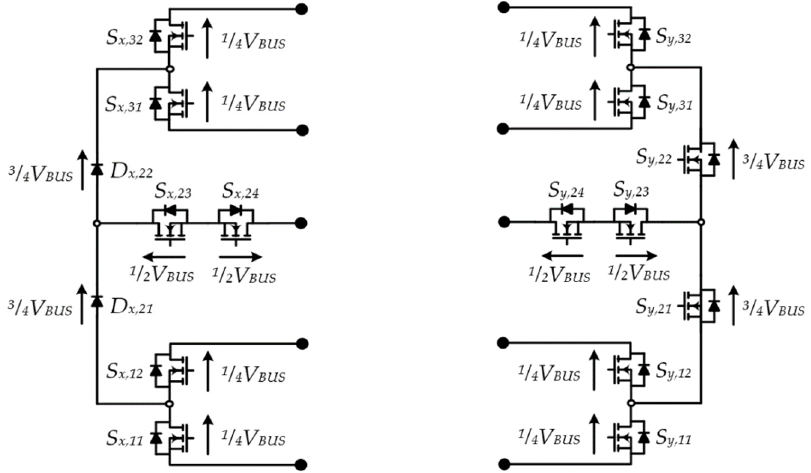
Figure 8. Maximum voltage stress that each cell of the E-Type Rectifier and Inverter can withstand at a steady state.